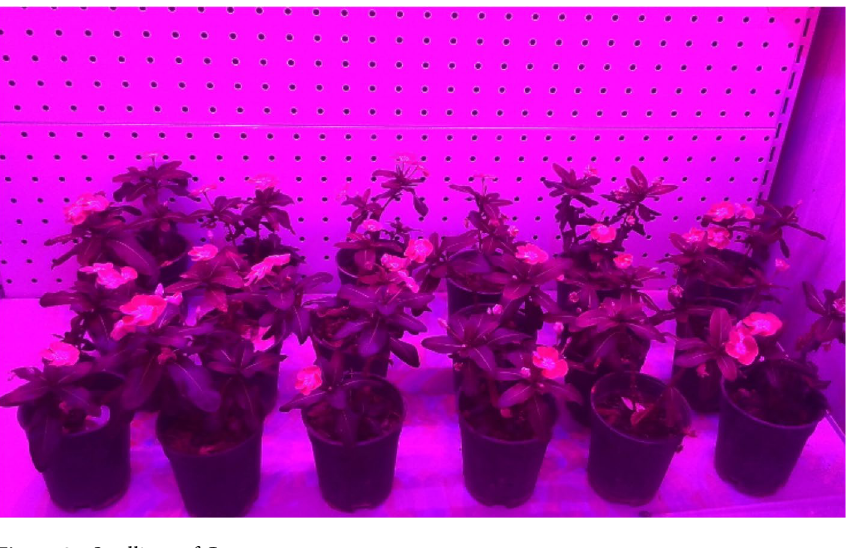
Figure 8. Seedlings of C. roseus